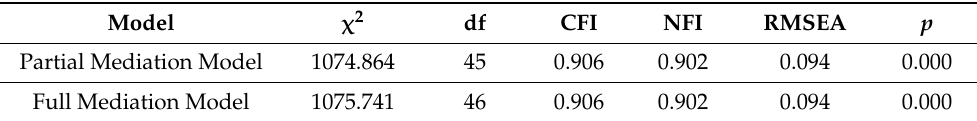
Table 3. Goodness of fit indexes for partial mediation model and full mediation model.